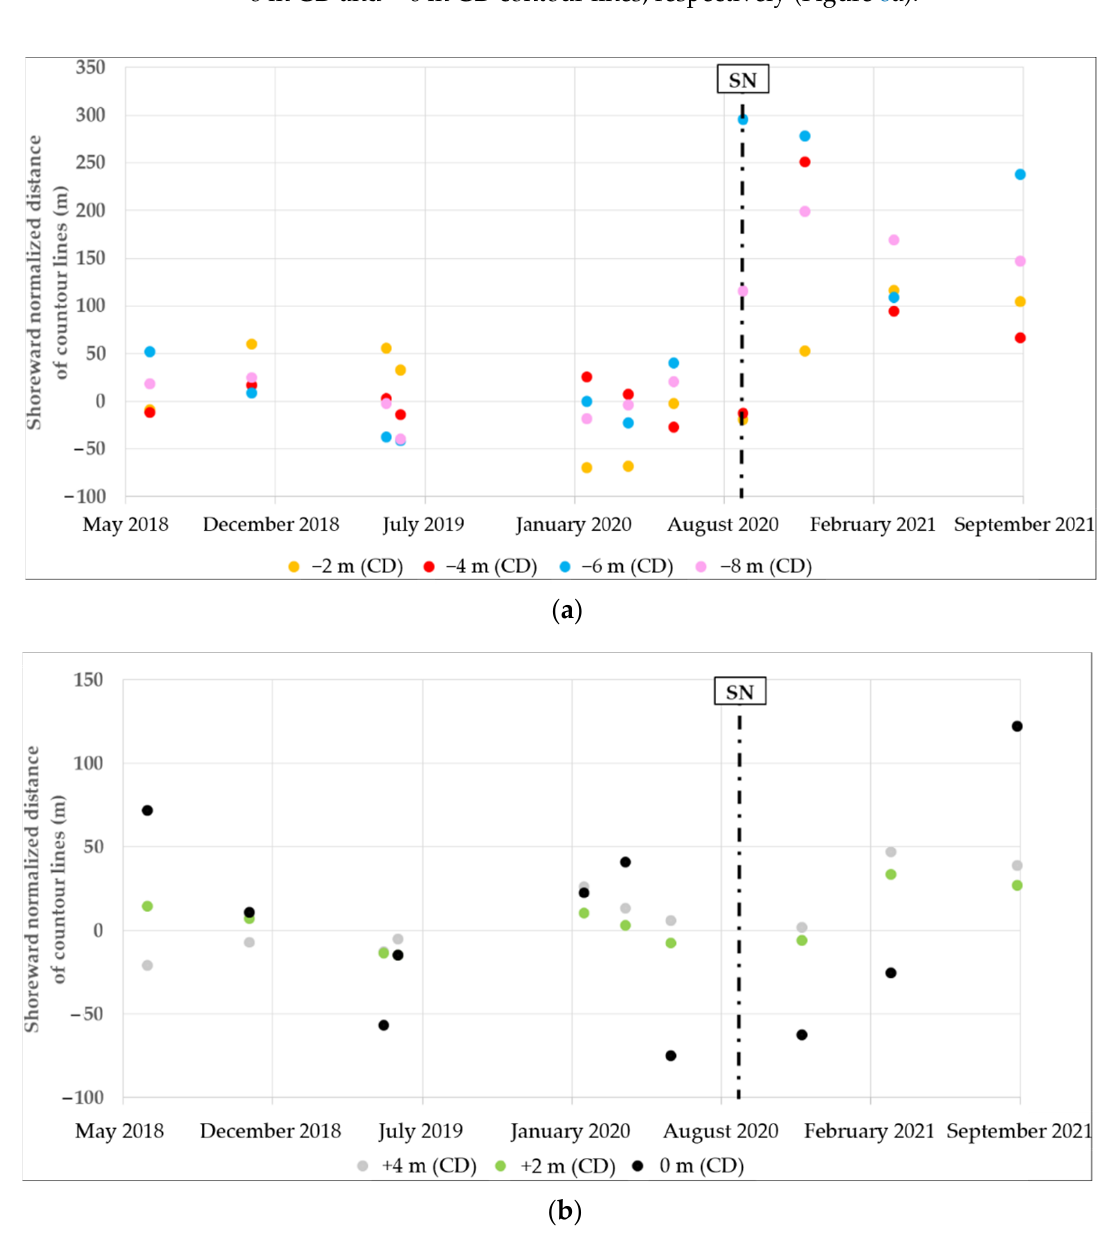
Figure 8. Temporal variation in the position of contour lines in the shoreface ( a ) and subaerial beach ( b ).